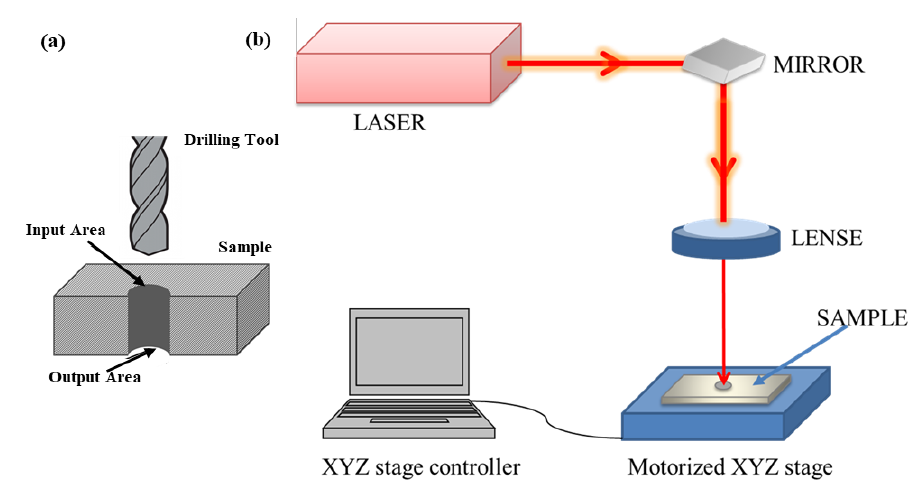
Figure 1. ( a ) Drilling process diagram and ( b ) laser processing setup. Table 1. Specifications of picosecond and nanosecond lasers.